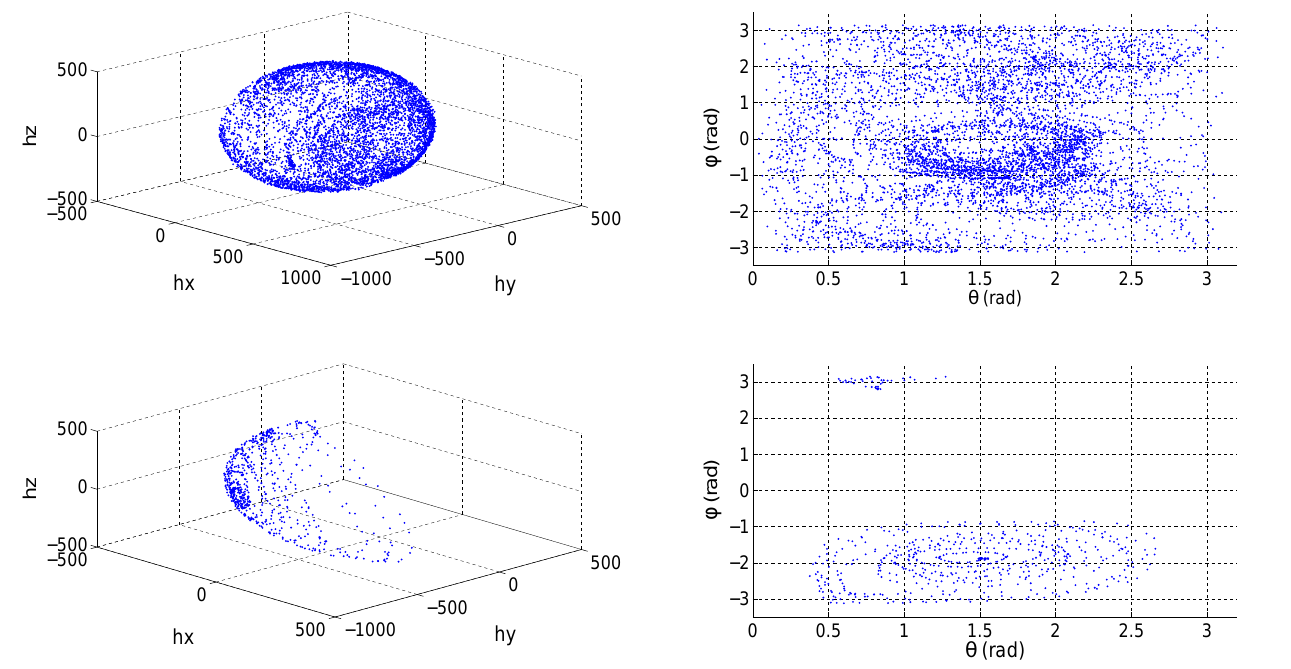
Figure 1. Gathered input magnetometer calibration datasets: well distributed ( top row ), ill-distributed ( bottom row ). 3D representation ( left column ) and projection of spherical coordinates ( right column